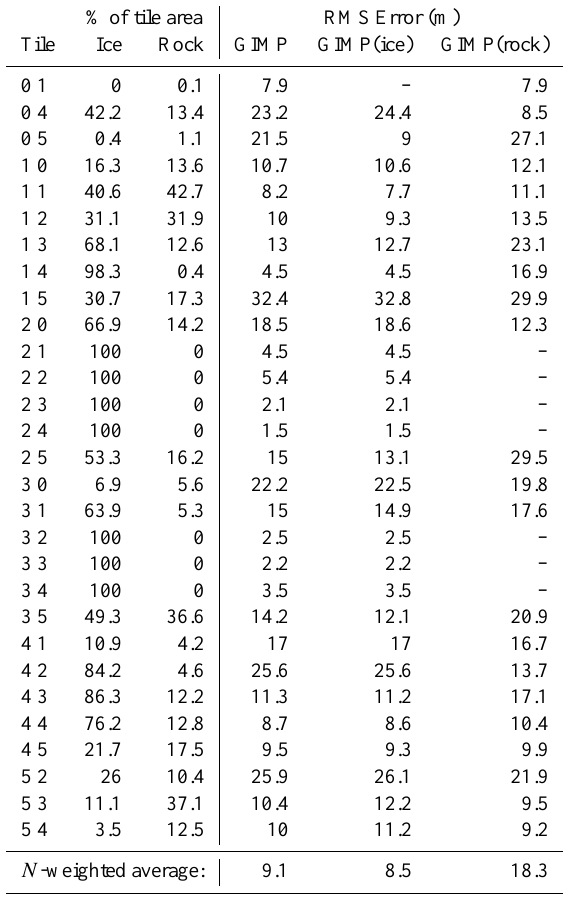
Table 2. Land classification and ICESat validation statistics for each GIMP DEM tile. Tile boundaries are delineated in Fig. 1.